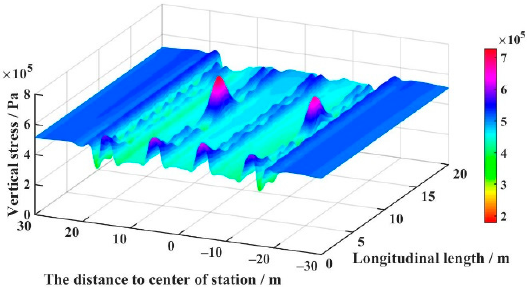
Figure 8. Stress fields of scheme 6 (D-13-24-57-68) on the plane P3.